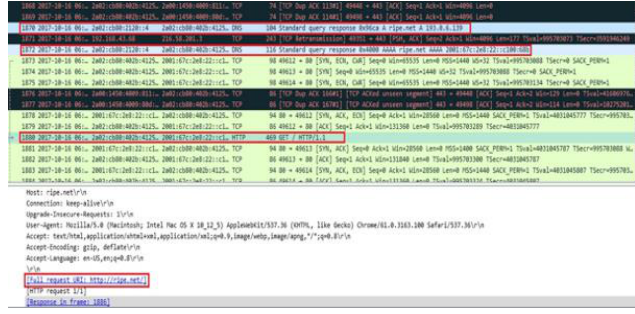
Fig. 12. Dual stack DNS query and response trace